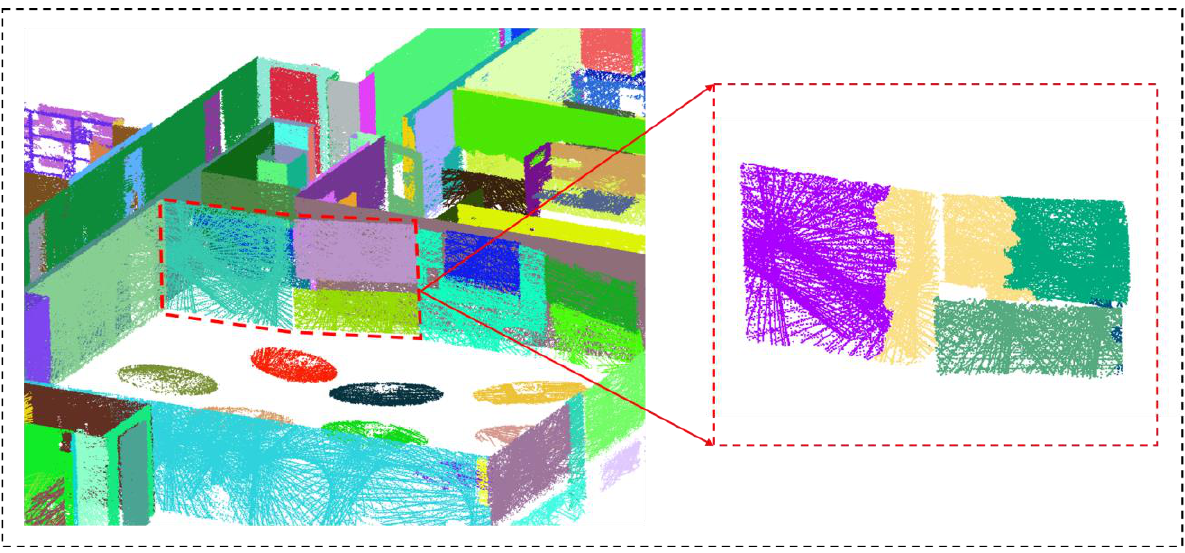
Figure 21. Example limitation for the proposed method where the normal directions have a moder- ate rate of